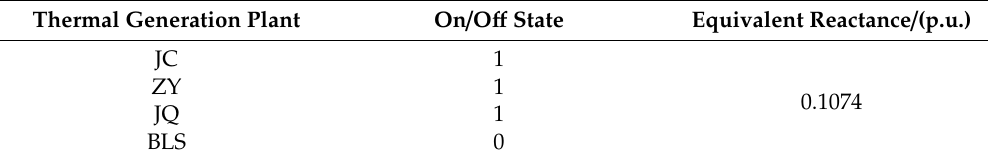
Table 5. Optimized day-ahead thermal generation plant commitment. Thermal Generation